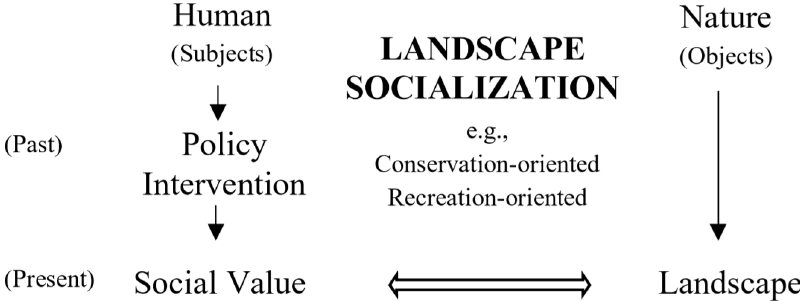
Figure 1. Conceptual framework for understanding human–nature connections.